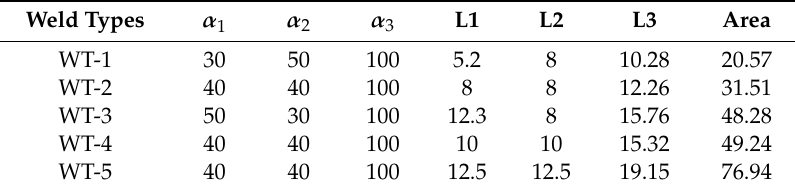
Table 7. Size of five weld types (unit: mm).